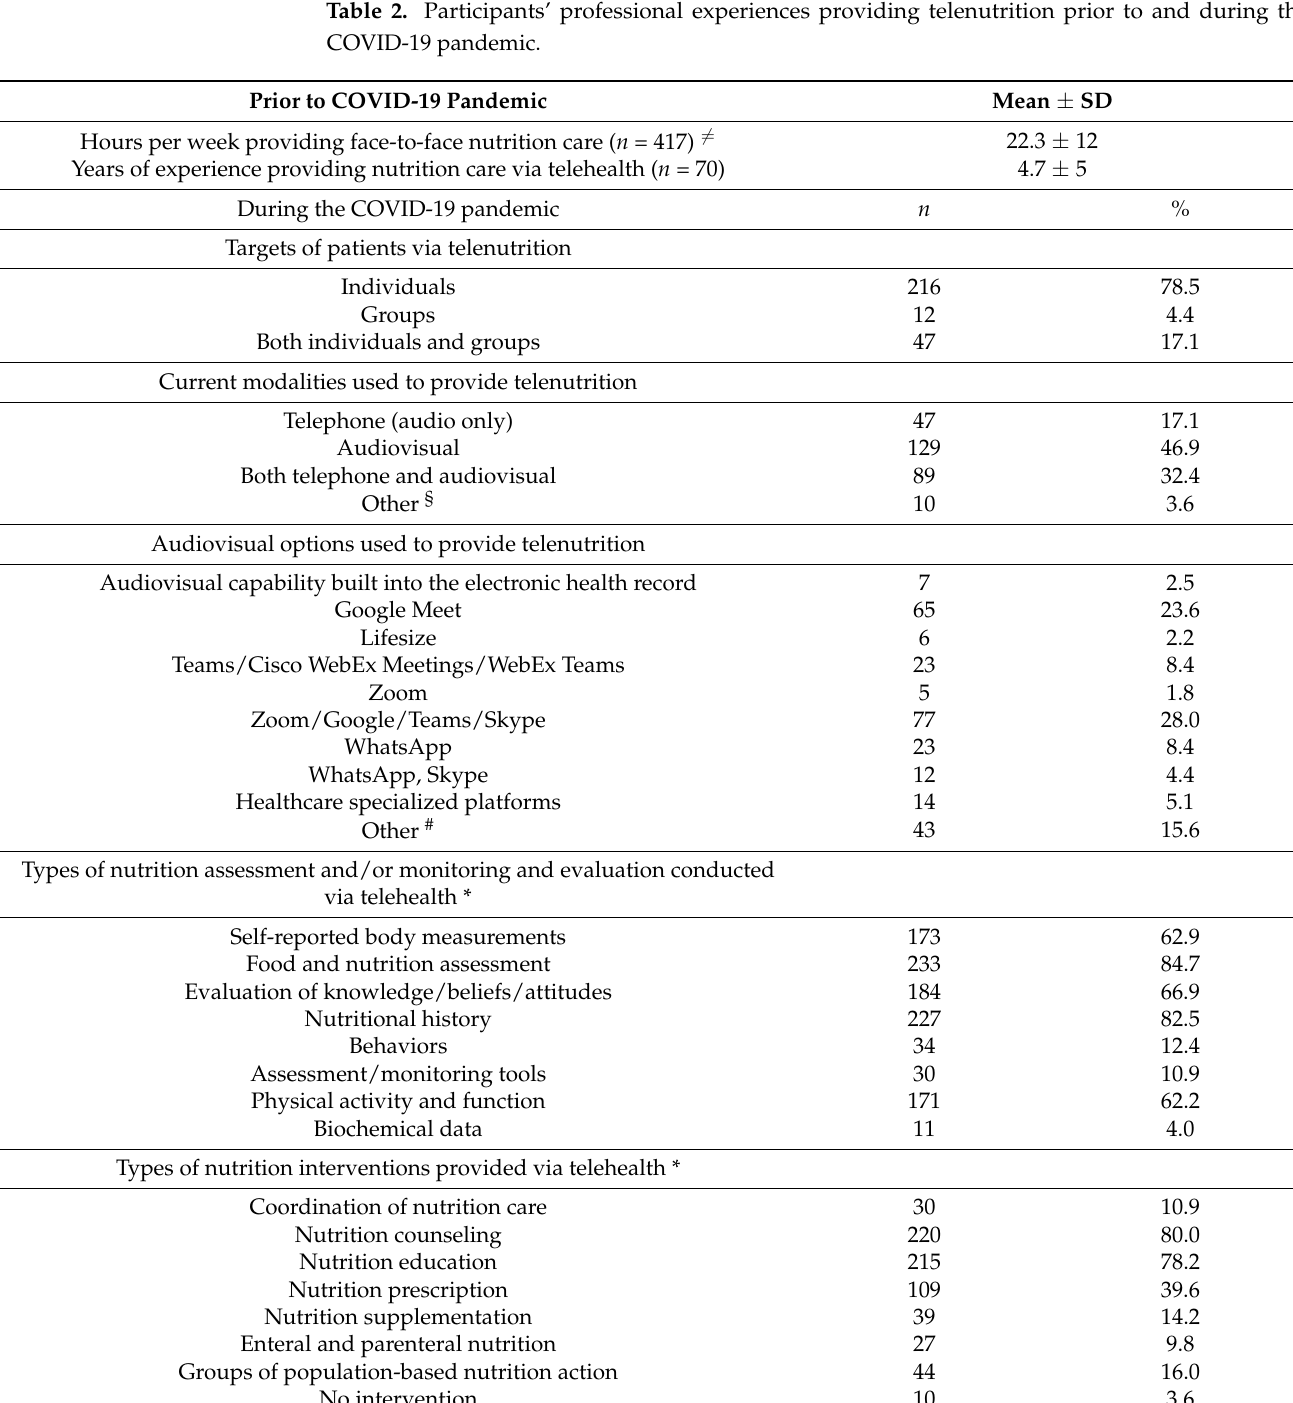
Table 2. Participants’ professional experiences providing telenutrition prior to and during the COVID-19